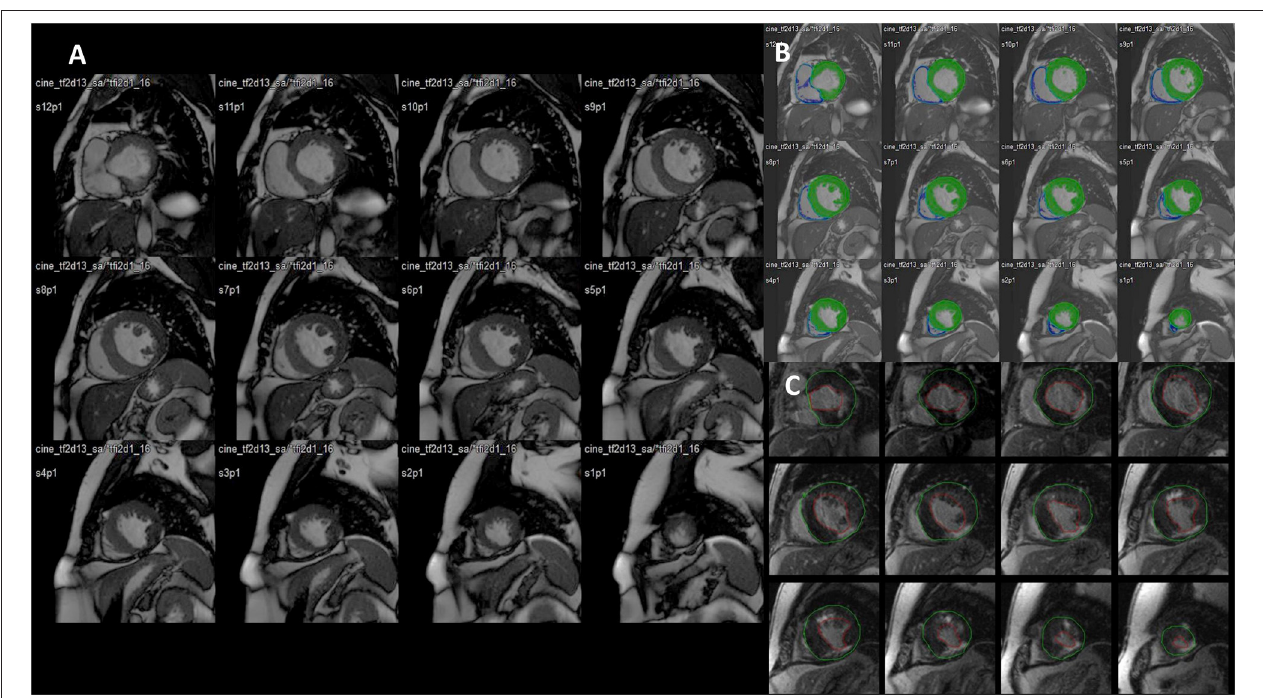
FIGURE 1 | (A) Stack of cine images (end-diastolic frames) from a patient with previous myocardial infarction. Twelve parallel slices (top panels, basal segments; middle panels, mid-ventricular segments; bottom panels, apical segments). Slice thickness 8mm, no gap. (B) The detection of the sub-epicardium and the sub-endocardium is performed semi-automatically (only the sub-epicardium is traced by the operator; mask mode). The left and right ventricle volumes and mass are automatically computed. (C) Late gadolinium enhancement images allow the precise depiction of two previous myocardial infarctions: one at the level of the inferolateral inferior wall (basal, mid, and apical segments), with a transmural involvement of the myocardium (transmurality: 75–100%), and one at the level of the anterior mid and distal segments with a non-transmural involvement (transmurality: